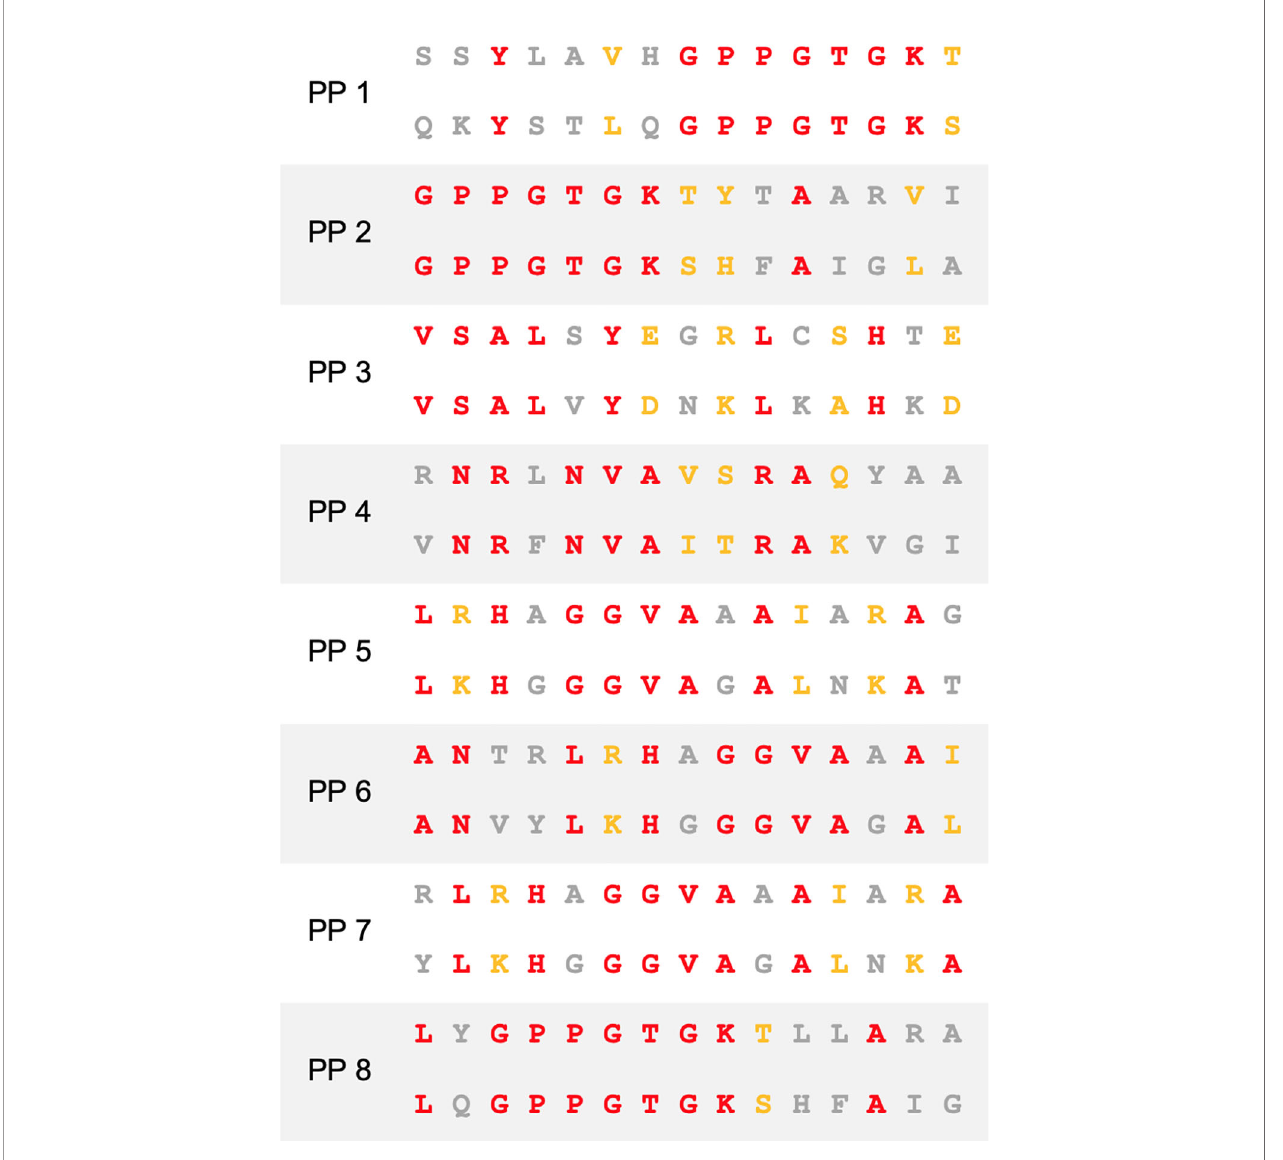
FIGURE 1 | Sequence homology between BCG and SARS-CoV-2. Amino acid sequence alignment of peptide pairs (PP) of BCG (top) and SARS-CoV-2 (bottom) used in this study. Red – identity. Yellow – similarity. Grey – no